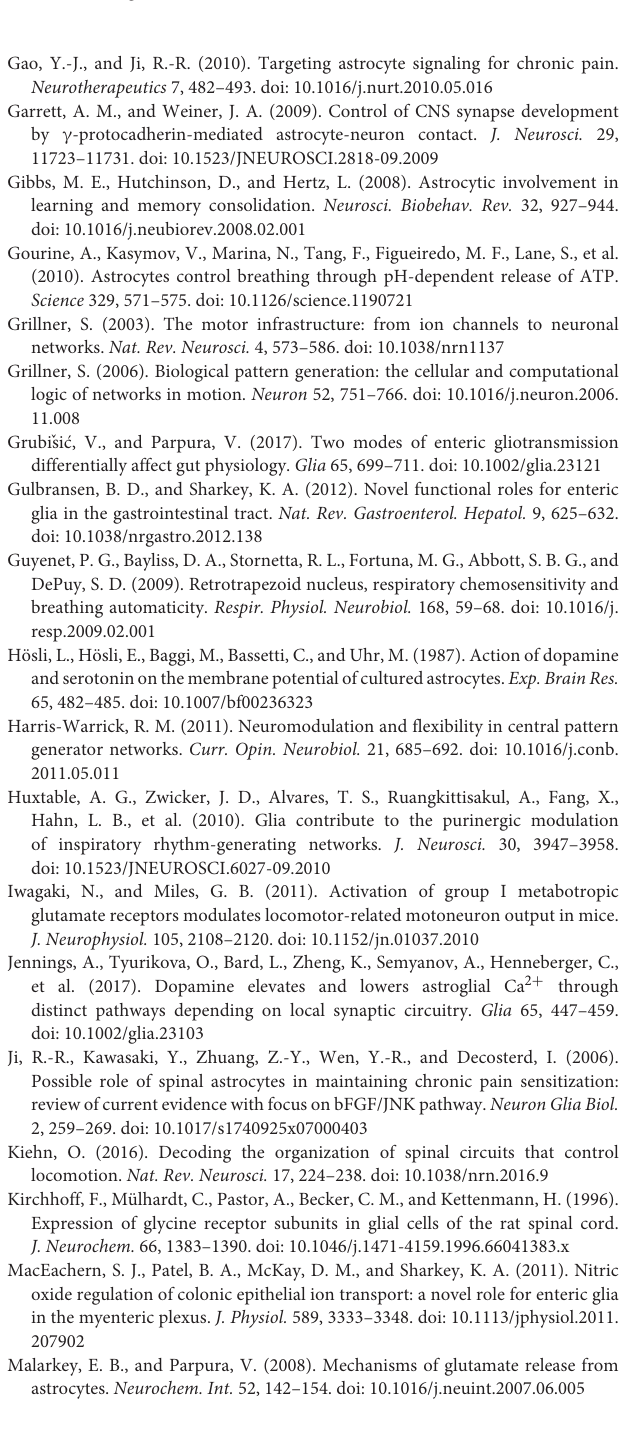
responded to glutamate, typically showing a more sustained ∆ F/F0 elevation, when CNO was absent. FIGURE S3 | Additional fictive locomotor bursting parameters for control (non-transgenic), GFAP::cre;hM3Dq and GFAP::cre;hM4Di neonatal spinal cords. (A) Bar chart showing the duration of fictive locomotor bursts in each of the three genotypes of mice used. (B) Bar chart showing the frequency of fictive locomotor bursts in each of the three genotypes of mice used. (C) Bar charts displaying the burst duration under control, CNO and wash conditions for control